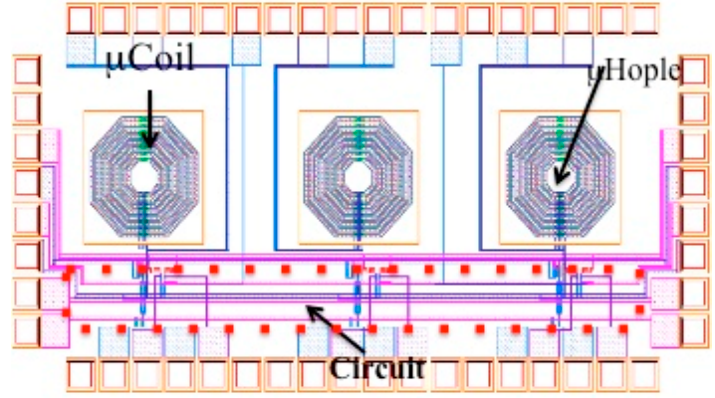
Figure 8. CMOS layout revealing three moils and associated pre- and post-amplifiers.